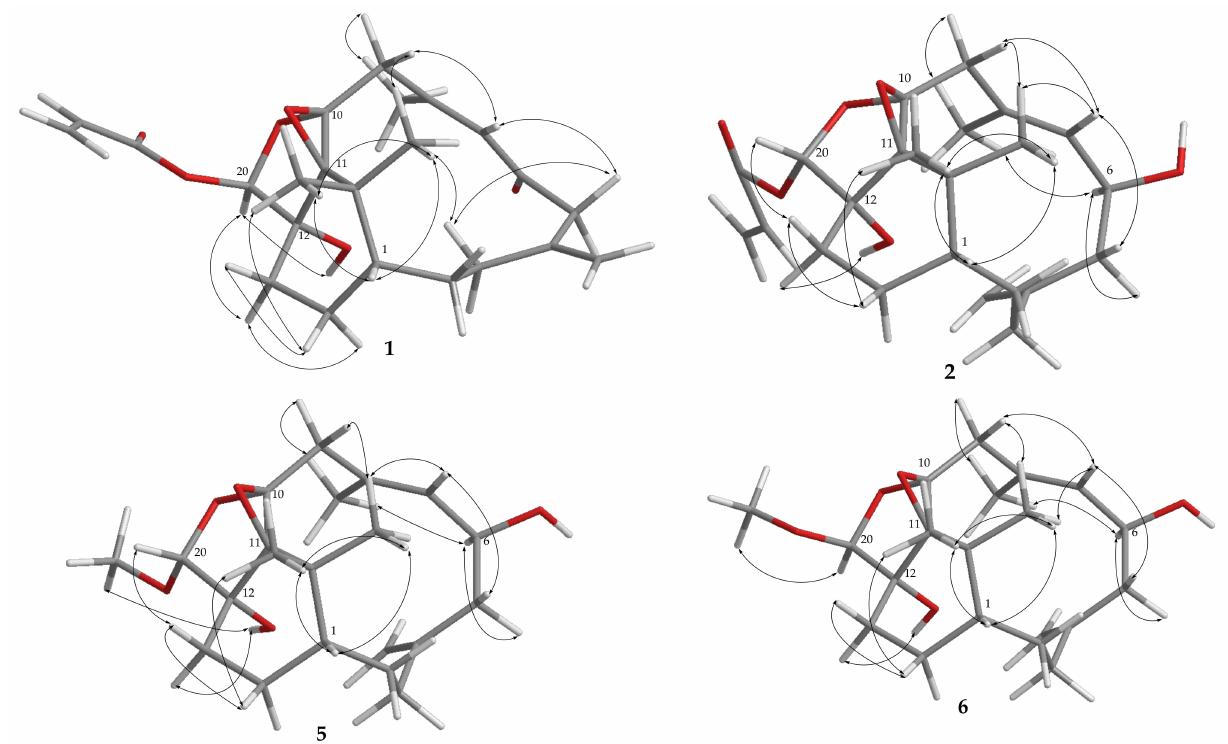
Figure 4. Selected NOE correlations of compounds 1 , 2 , 5 , and 6